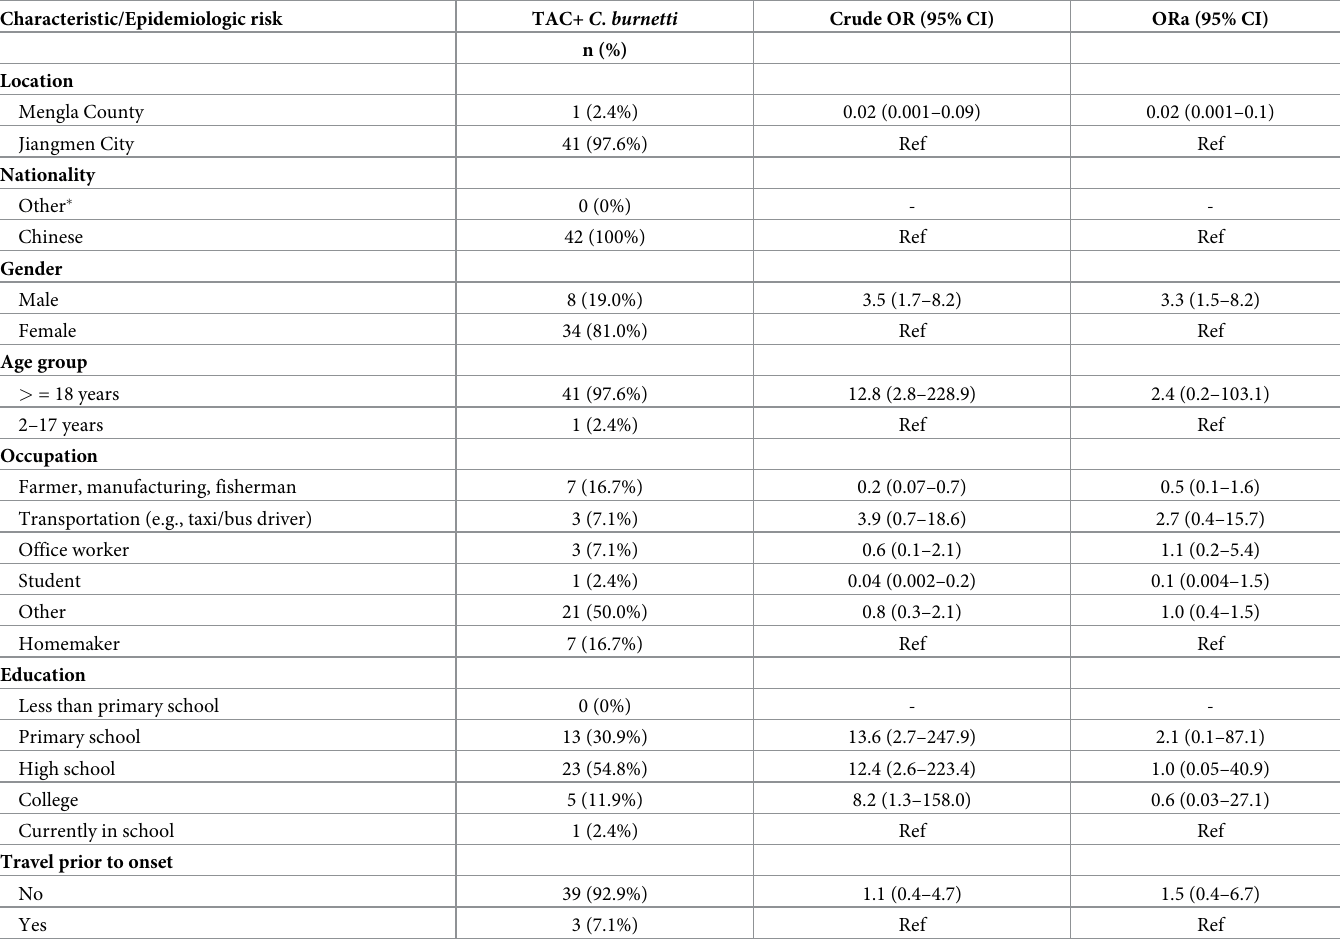
Table 6. Association between patient characteristics/epidemiologic factors and detection of Coxiella burnetii on TaqMan Array Card (TAC) diagnostic testing plat- form, China, June 2017–July